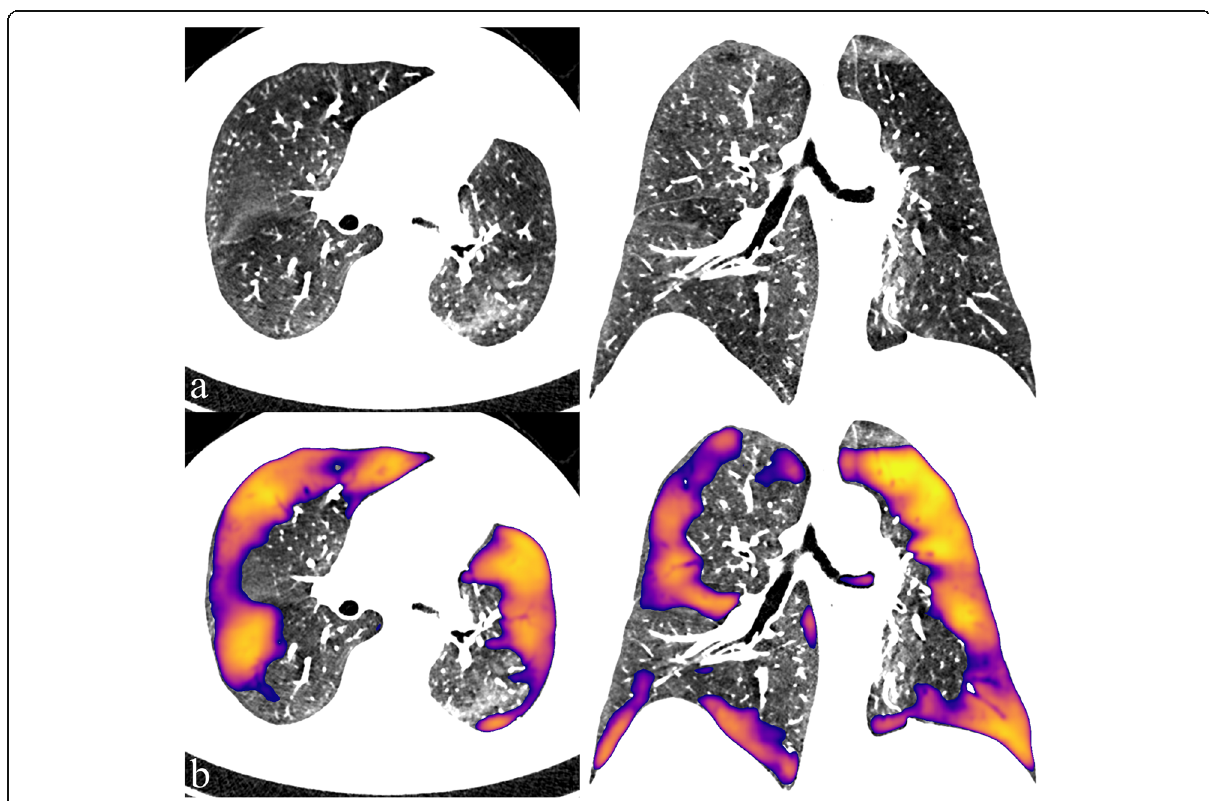
Fig. 7 One patient with previous upper lobe left pneumonectomy, and the remaining lung parenchyma was low in HU, resulting in large false positive predictions by the convolutional neural network. HU Hounsfield